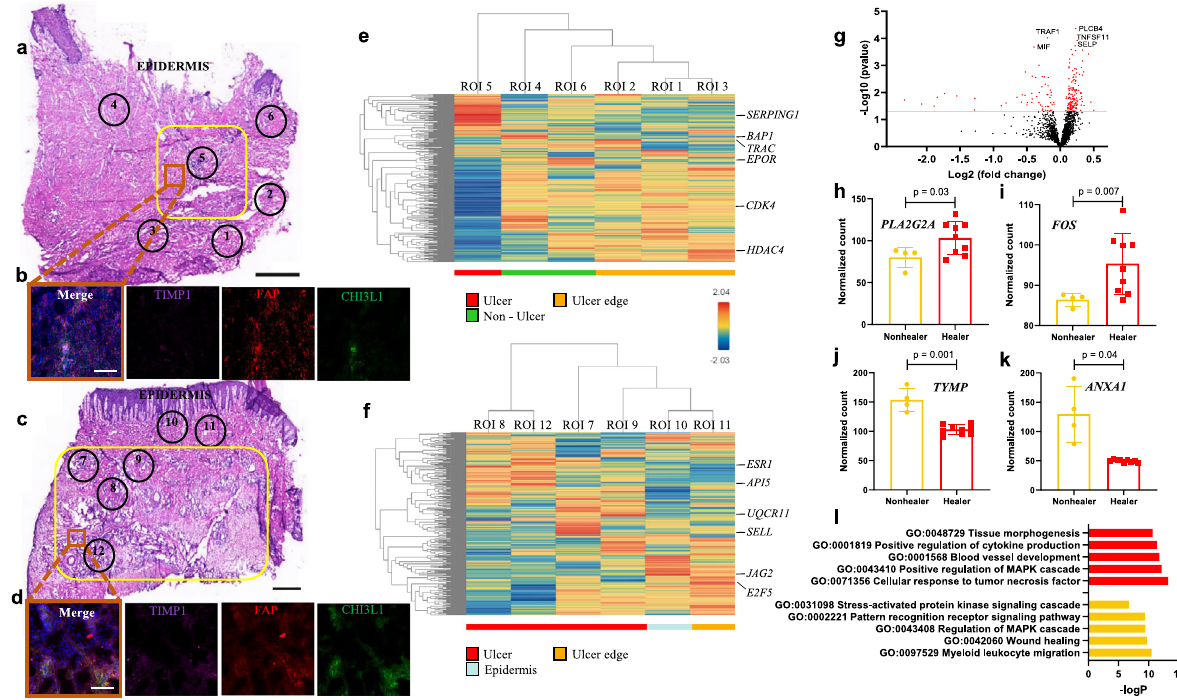
Fig. 6 Exploring the spatial transcriptome of DFU-Healers and DFU-Non-healers. a , c Representative H&E-stained sections from a ( a ) non-healing and ( c ) healing DFU. Yellow box demarcates the ulcer area and numbered circles the ROIs selected for sequencing. b , d Immuno fl uorescence staining for HE- Fibro markers TIMP1 (purple), CHI3L1 (green), and pan- fi broblast marker FAP (red) performed on a serial section from the same sample. DAPI was used for nuclear counterstain. The location of the image capture is noted with an orange box on ( a ) and ( c ). e , f Hierarchical clustering analysis heatmaps depict the transcriptomic pro fi les of the selected ROIs. The most highly expressed gene per ROI is highlighted. ROIs were annotated based on their location as Ulcer (red), Non-Ulcer (green), Ulcer edge (orange), and Epidermis (light blue). Expression levels are shown according to the gradient middle right (blue low to red high). g Volcano plot showing DE analysis results from ROIs within the ulcer in Healers (2 patients, 9 ROIs) vs Non-healers (2 patients, 4 ROIs). Each dot represents a gene, with red ones being above the signi fi cance threshold. The top fi ve genes are highlighted. h – k Selected notable genes upregulated in Healers ( h , i ) and Non-healers ( j , k ). Data represent mean ± SD from n = 4 ulcer ROIs of 2 Non-healers and n = 9 ulcer ROIs of 2 Healers. Two-tailed unpaired t -test with Benjamini – Hochberg procedure for adjusted p -values was used to calculate p -values. l GO analysis for biological processes enriched in Healers (top, red) and Non-healers (bottom, yellow). Stainings were performed three times with two biologically independent patient samples per group. Scale bars are 1 mm in ( a , c ) and 100 μ m in ( b , d